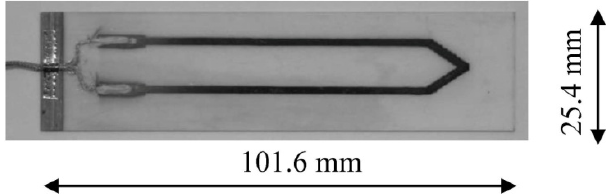
Figure 15. Direct-Write thermocouple test coupon provided by MesoScribe,